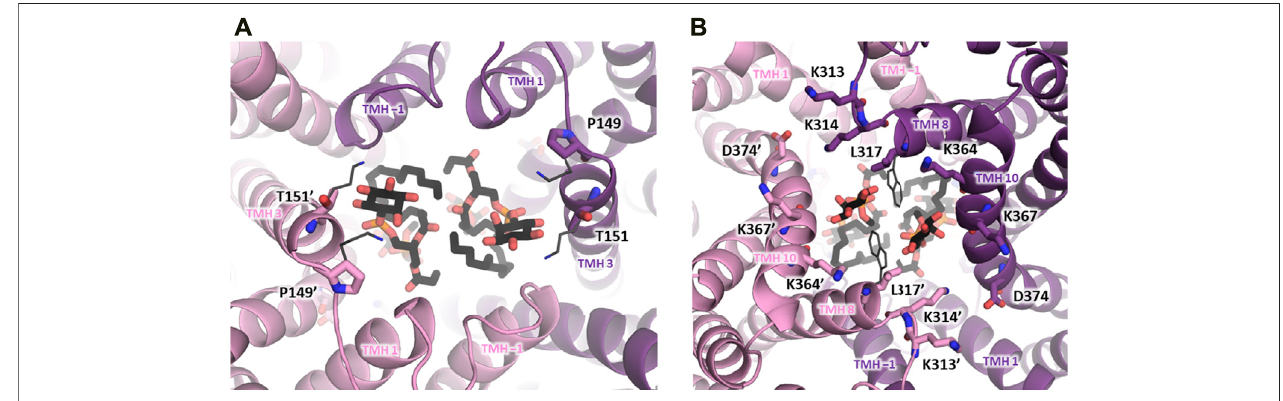
FIGURE 4 | Dimerization subdomain of human NHA1. A homology-based model of human NHA1 is shown (see text), with the two protein subunits in purple and pink color. Lipid residues have been copied from the bison NHA2 structure (Matsuoka et al., 2022) and are shown in black stick representation for illustration. (A) View from the extracellular side, positions of lysine residues from bison NHA2 (K168, K170) suggested to interact with the phosphate groups of PIP 2 are shown in dark grey thinstickrepresentation,withtheircorrespondingresiduesinhumanNHA1labeled (P149,T151). (B) Viewfromthecytoplasmic side,withputativelipid-interacting lysineresidues shown instick representation and labeled.ResidueD374can possibly form asaltbridge withK314 ’ .The locationoftheW336 residue from bison NHA2, reported to interact with lipid inositol group, is shown in dark grey thin stick representation, with the corresponding L317 residue in human NHA1 labeled.